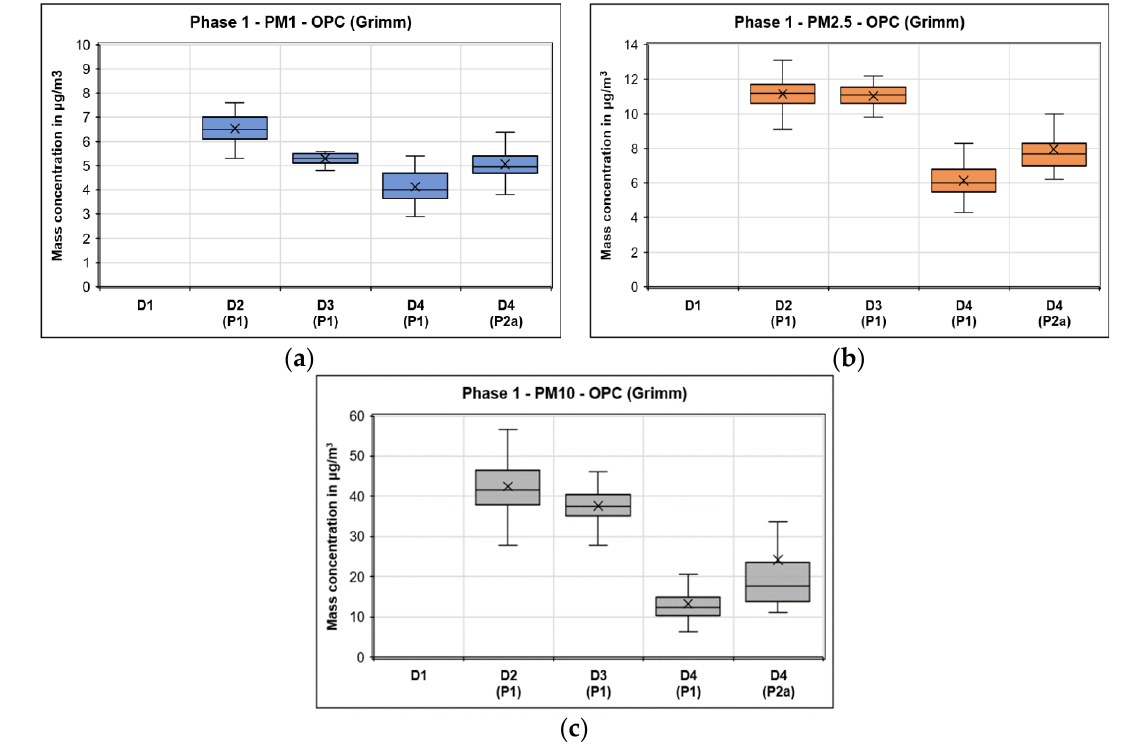
Figure 17. Phase 1 ( a ) PM1, ( b ) PM2.5, and ( c ) PM10 concentrations.